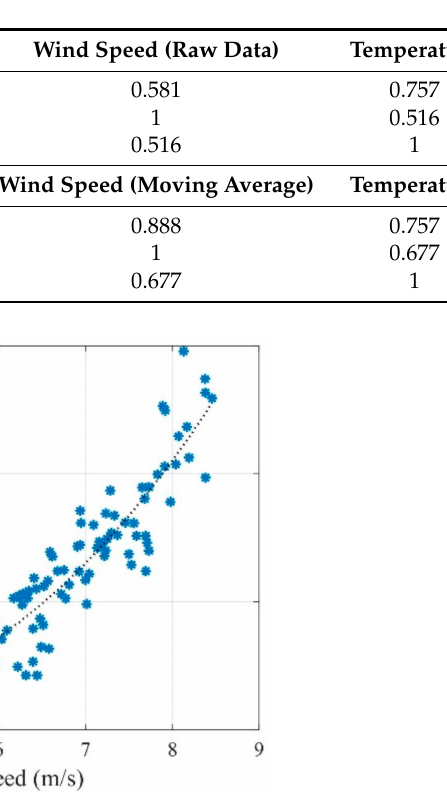
Table 5. Correlation coefficients between rotation speed, wind speed, and temperature.